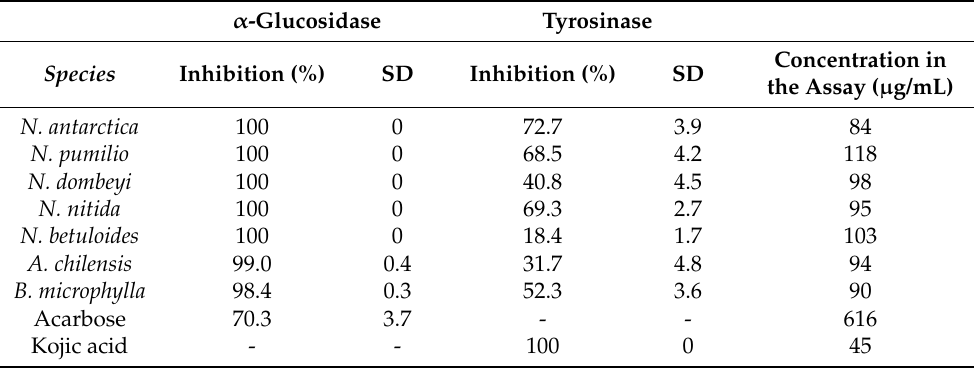
Table 3. α -glucosidase and tyrosinase inhibitory activity of plant extracts. α -Glucosidase